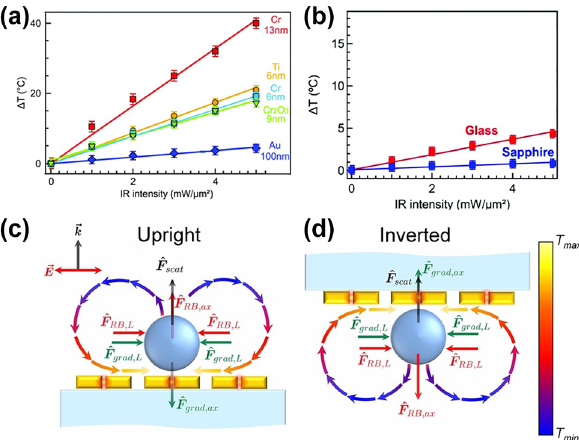
Figure 5: Plasmonic heating of various substrates. (a) Temperature increase in a 300 nm diameter single nanohole plotted against laser intensity and as a function of adhesion layer material and its thickness. (b) Temperature increase in a glass (red) and sapphire (blue) substrate versus laser intensity. Figures reproduced with permission from [54], Copyright 2020. The Royal Society of Chemistry. A schematic of (c) upright and (d) inverted is the optical scattering force, F and configurations, where F scat grad F RB are the gradient and the thermal forces, respectively, and L and ax indicate laterally and axially directed forces, respectively. The arrows indicate the direction of natural convection with colour representing the relative temperature, T . Figures reproduced with permission from [133], Copyright 2012 The Optical